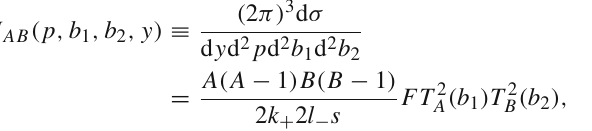
target, which is the only dimensional variable after the